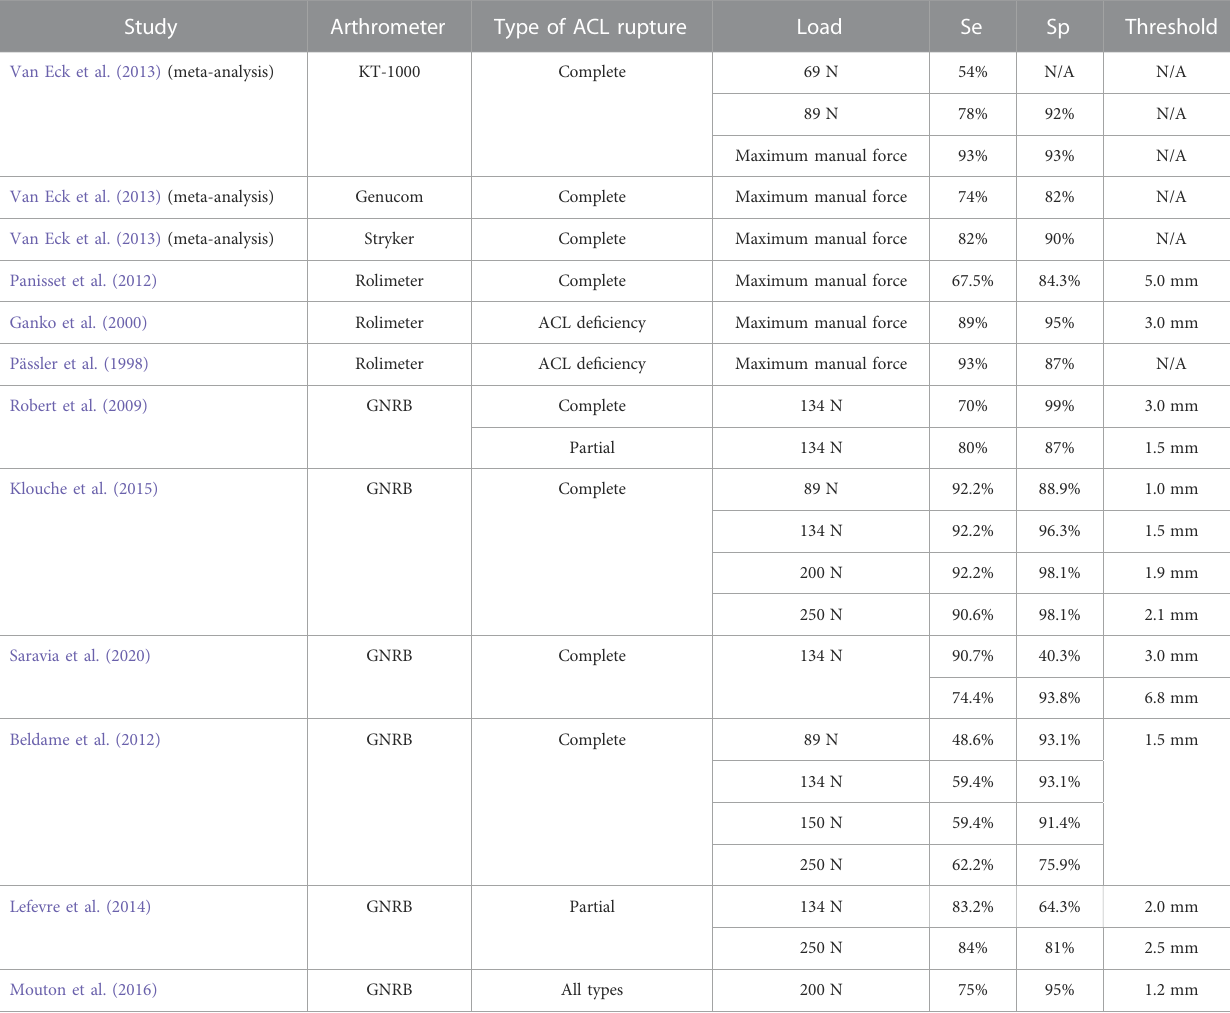
TABLE 3 Results of the ROC curve analysis for different